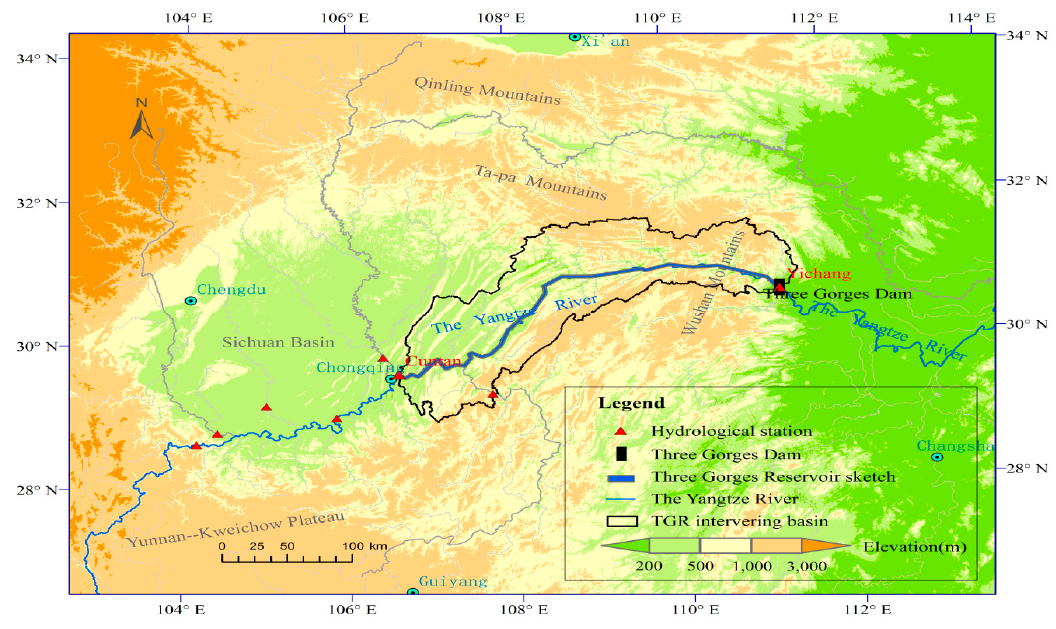
Figure 1. The Three Gorges Reservoir (TGR) intervening basin and its surrounding geographical